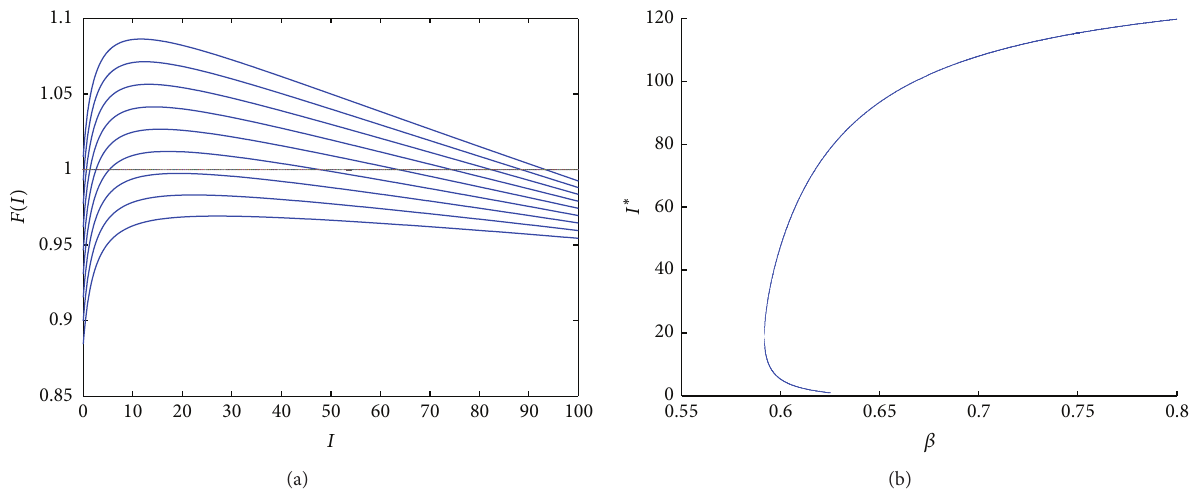
Figure 1: (a) Plot of the function 𝐹(𝐼) with different values of the transmission coefficient 𝛽 . (b) Backward bifurcation when the transmission coefficient 𝛽 varies. Other parameters: Π = 100 , 𝜇 = 1/45 , 𝑤 = 1/20 , 𝜖 = 0.4 , 𝜉 = 0.6 , 𝜎 1 = 0.7 , 𝜎 2 = 0.4 , 𝜓 = 0.5 , 𝑞 = 1 , ℎ = 1 , 𝜂 1 = 0.4 , and = 0.7 𝜂 2